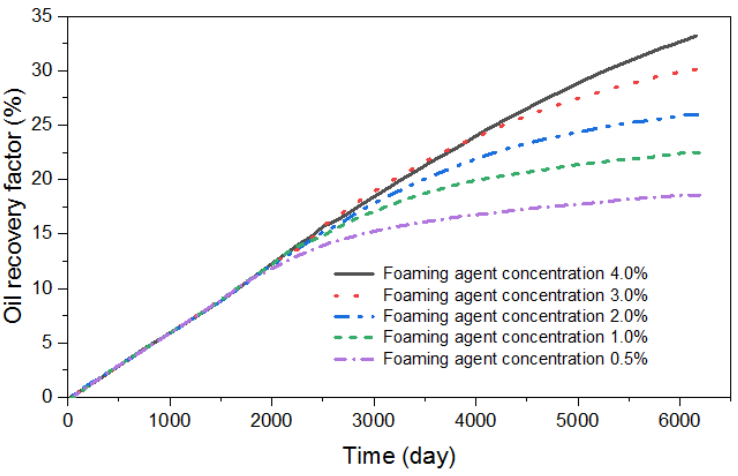
Figure 19. The comparison of huff-n-puff oil recoveries under different foaming agent concentrations. According to the foaming effect of the model experiment, the foaming volume and half-life can be increased by using a high concentration of foaming agent. The numerical adsorption and the cost of the foam system, the foam concentration is 3.0 ∼ 4.0% in the early stage of 1 ∼ three cycles, 2.0 ∼ 3.0% in the middle stage of 4 ∼ 6 cycles, and 1.0 ∼ 2.0% in